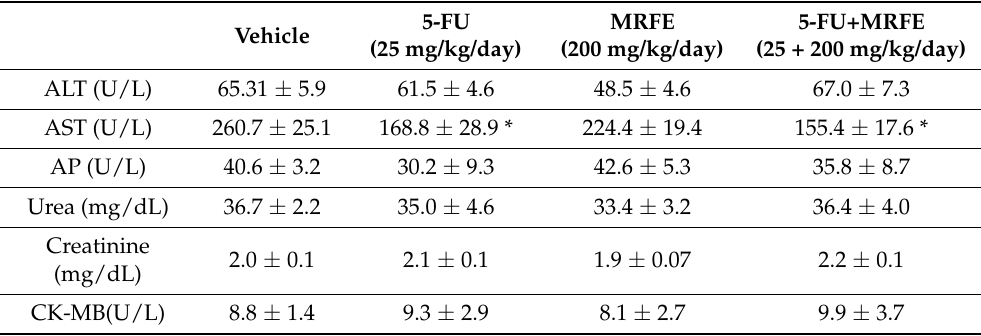
Table 3. Effect of 5-FU associated with MRFE on biochemical parameters in animals transplanted with S180 tumor.